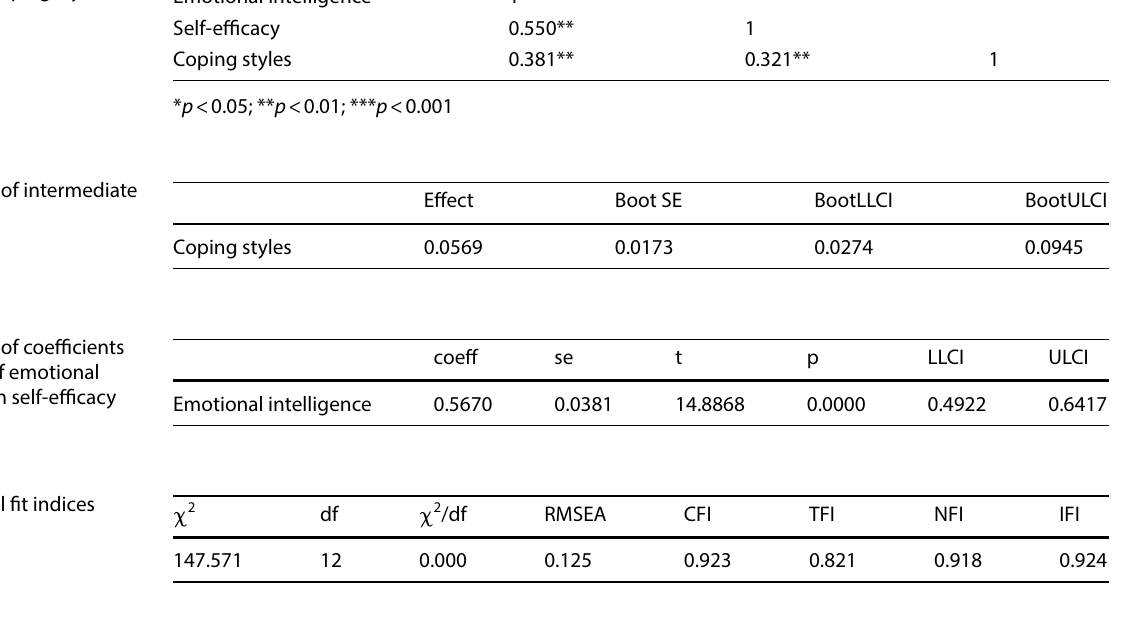
Table 1 Correlation matrix of emotional intelligence, self- efficacy, and coping styles